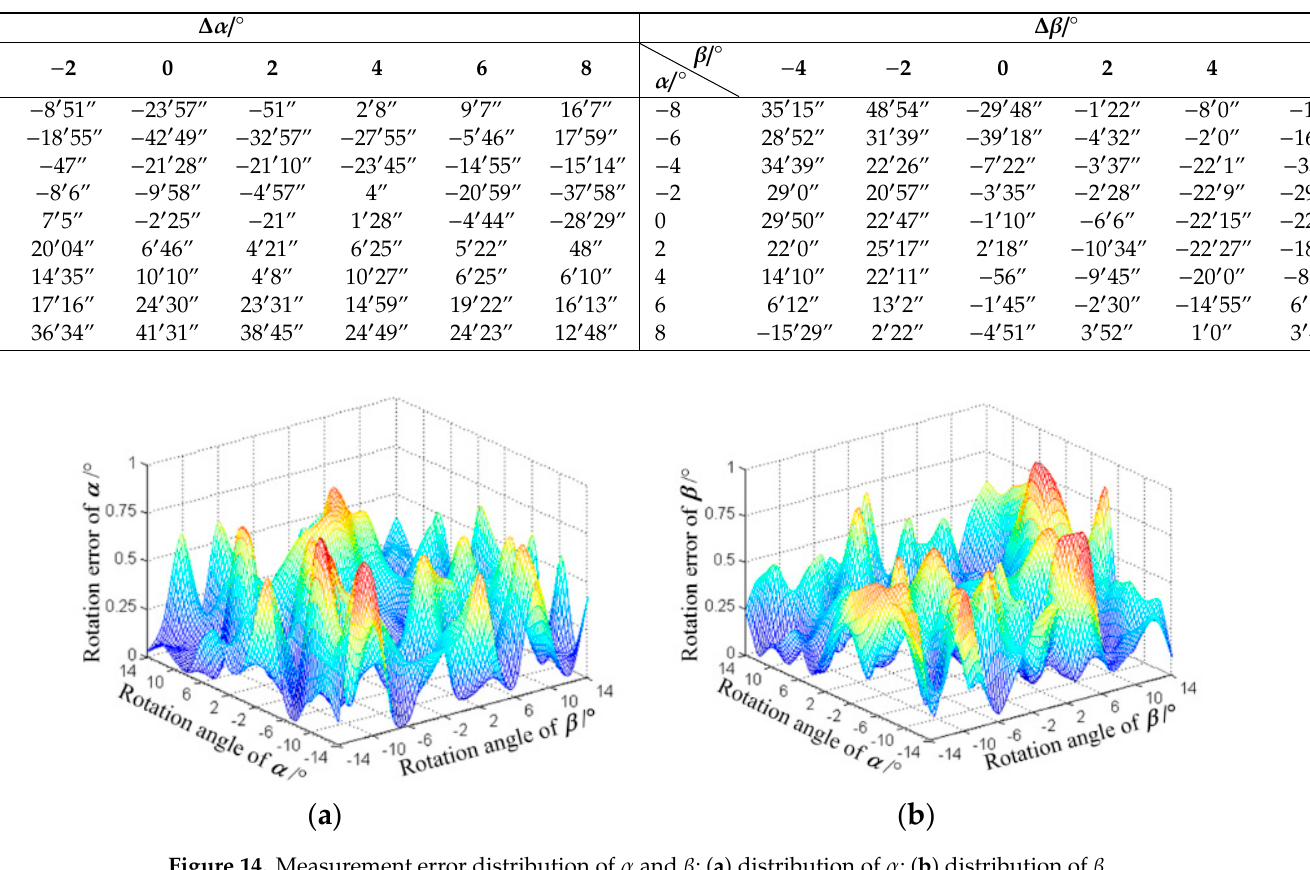
Figure 14. Measurement error distribution of α and β ; ( a ) distribution of α ; ( b ) distribution of β .